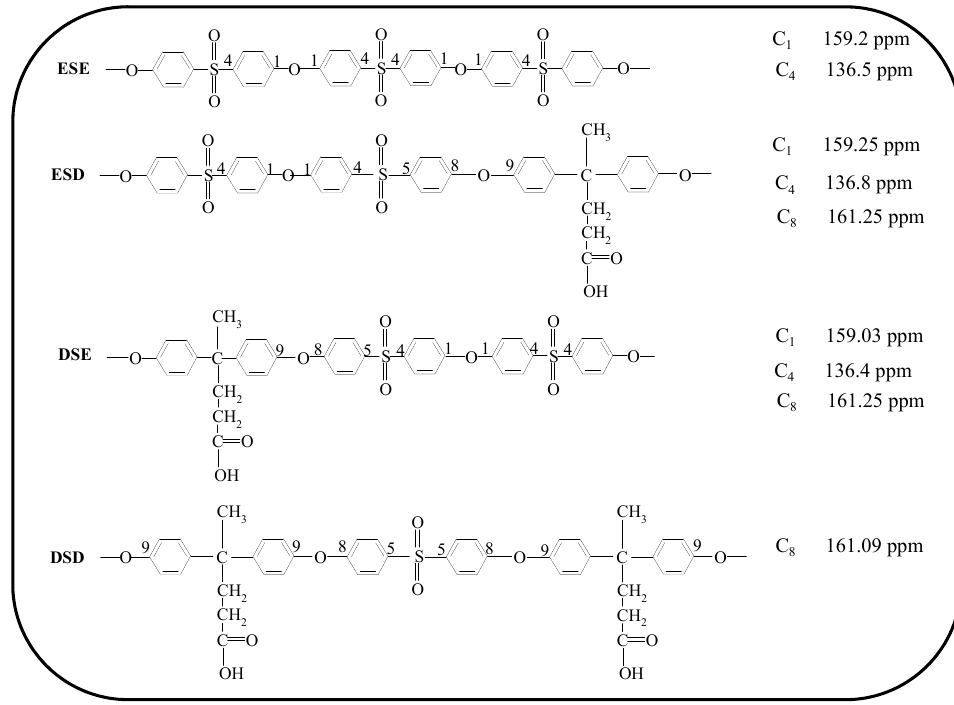
Scheme 2. Structures of the triads sequences centred on diphenyl sulfone (S) moiety, and the chemical shifts of their carbons C1 and